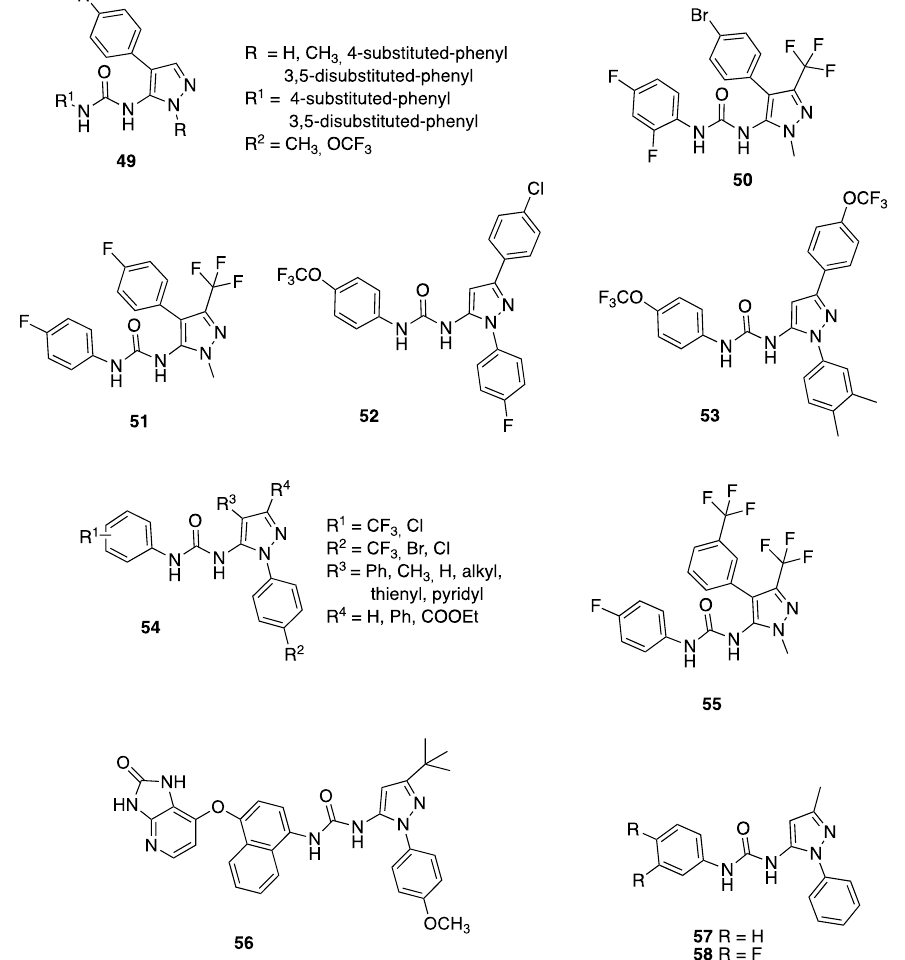
Figure 8. 5-Pyrazolyl-ureas reported as antiparasitic agents and as potassium channel activators.